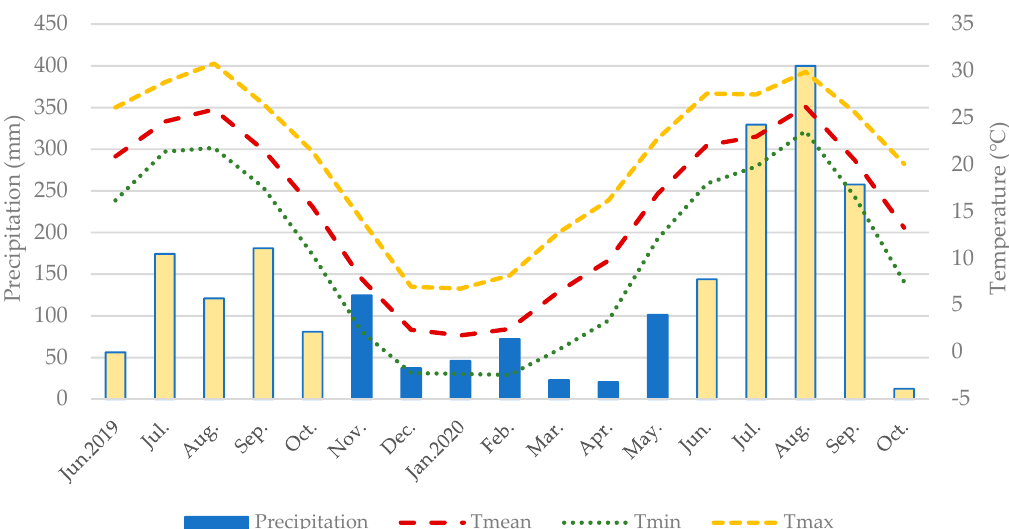
Figure 2. Total amount of precipitation, monthly mean (Tmean), minimum (Tmin) and maximum (Tmax) air temperature recorded for two years. (The precipitation during the growth period of forage rice is indicated in yellow.)